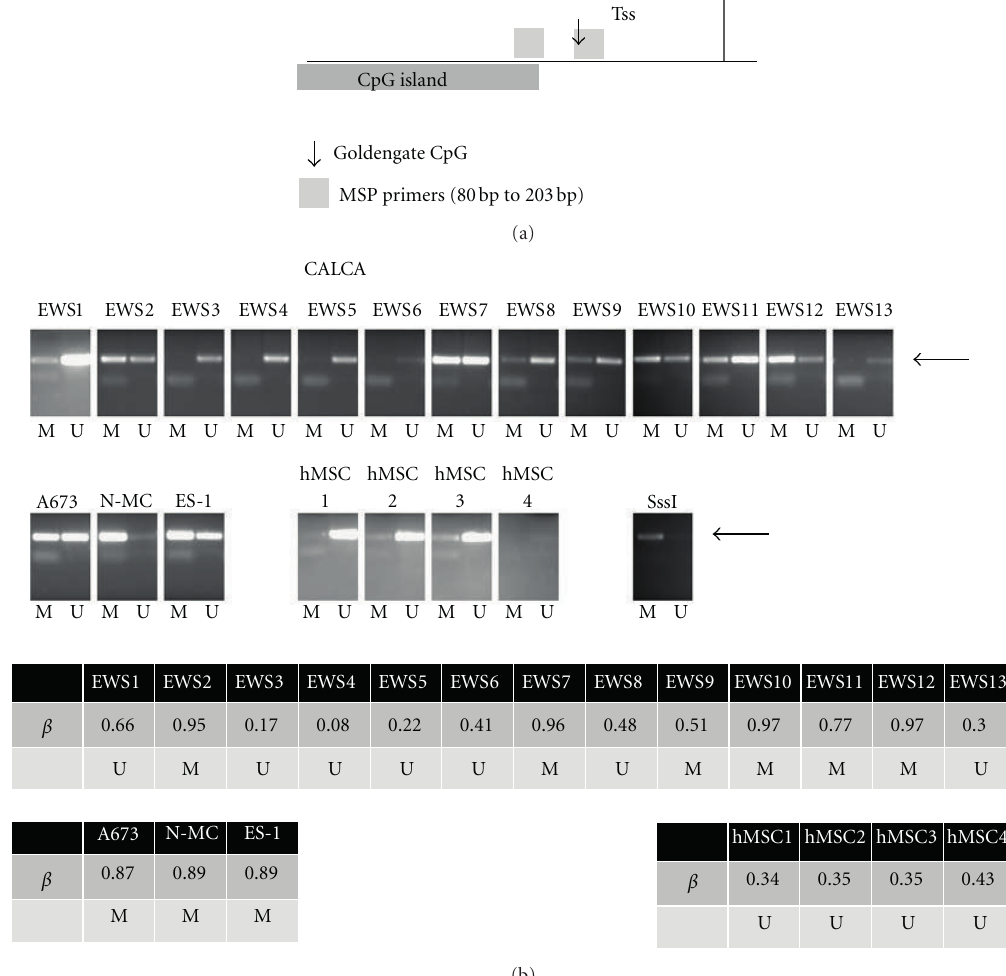
Figure 3: Validation of bead chip methylation analysis. (a) Schematic diagram of CALCA showing the location of the transcription start site (Tss) in relation to the CpG island, MSP primers, and the CpG analyzed by the bead chip assay. (b) MSP analysis of EWS primary tumors, EWS cell lines, and hMSCs. M: methylated; U: unmethylated. Bead chip methylation β values for EWS primary tumors EWS1–EWS13 are also shown. Tumors were considered methylated if the β score was greater than